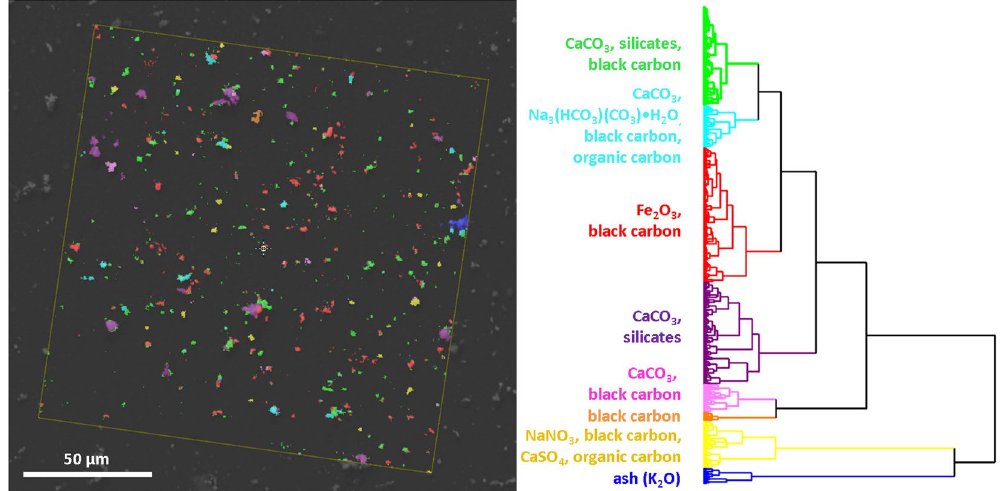
Figure 5. Superposition of the SEM image of the aerosol sample with the virtual image of the HCA of the MSHSI dataset and assignment of chemical species to the sub-clusters, based on extracted cluster